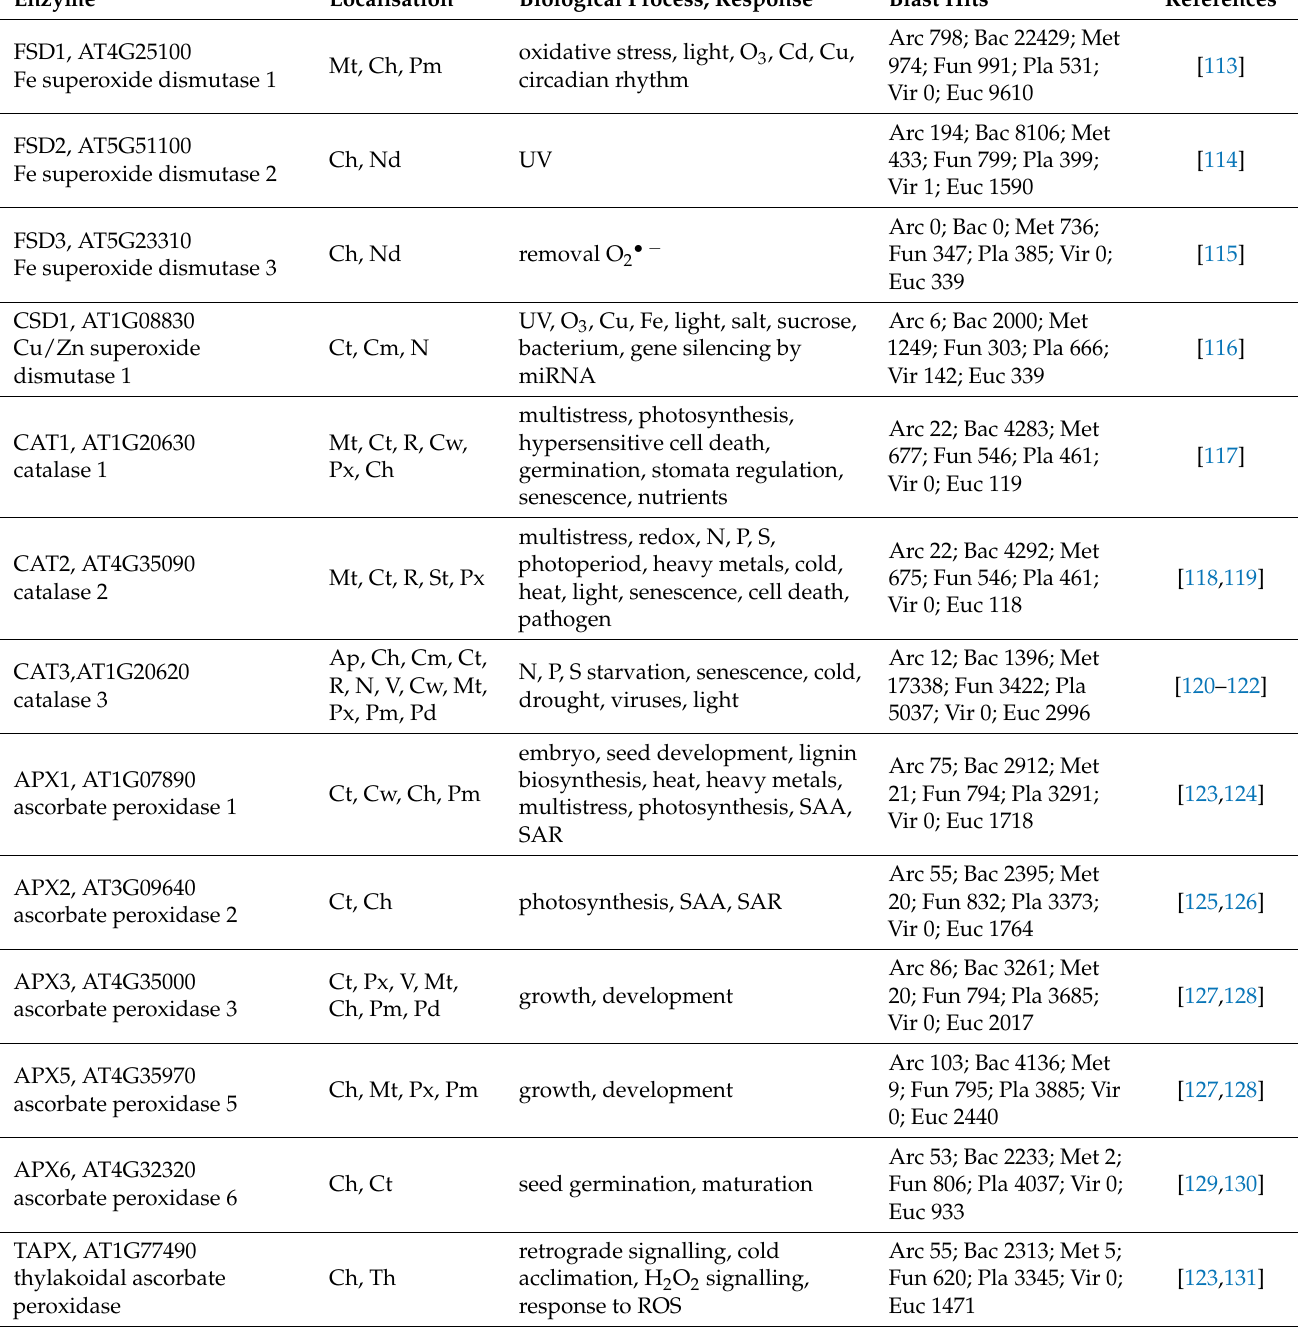
Table 2. Gene Ontology (TAIR) for selected antioxidative enzymes ( A. thaliana ). Localisation: Ap, apoplast; Ch, chloroplast; Cm, cytoplasm; Ct, cytosol; Cw, cell wall; En, endosome; Er, endoplasmic reticulum; Ga, Golgi apparatus; Mt, mitochondrion; N, nucleus; Nd, nucleoid; Pd, plasmodesma; Pm, plasma membrane; Px, peroxisome; R, ribosome; Sm, stroma; St, stromule; Sv, secretory vesicle; Th, thylakoid; V, vacuole. Blast hits: Arc, Archae; Bac, Bacteria; Met, Metazoa; Fun, Fungi; Pla, Plants; Vir, Vir; Euk, other